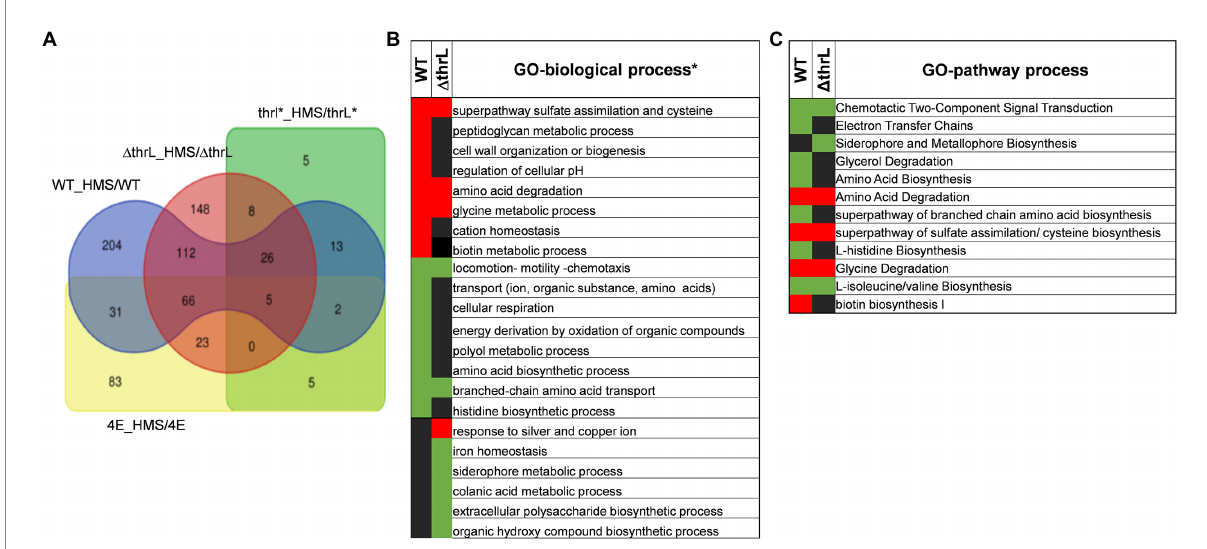
FIGURE 8 Effect of L-homoserine on the transcriptome of the MG1655 (WT), MG1655 carrying the allele ( thrL* ) or deleted for thrL ( Δ thrL ) and homoserine- adapted HMSCR4E (4E). The Venn diagram (A) shows the overlap of differentially expressed genes between the strains treated with L-homoserine versus untreated compared to the wild type strain. In (B,C) are reported genes ontology analysis in terms of biological (B) and metabolic processes (C) that are the most affected in the transcriptomes of WT and Δ thrL mutant in response to L-homoserine versus untreated. The concentration of L-homoserine used in the culture medium was 10